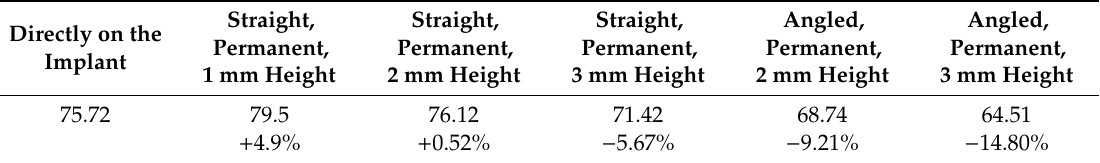
Table 1. Average Implant Stability Quotient values according to height compared to those measured directly on the implant (% increase or decrease).